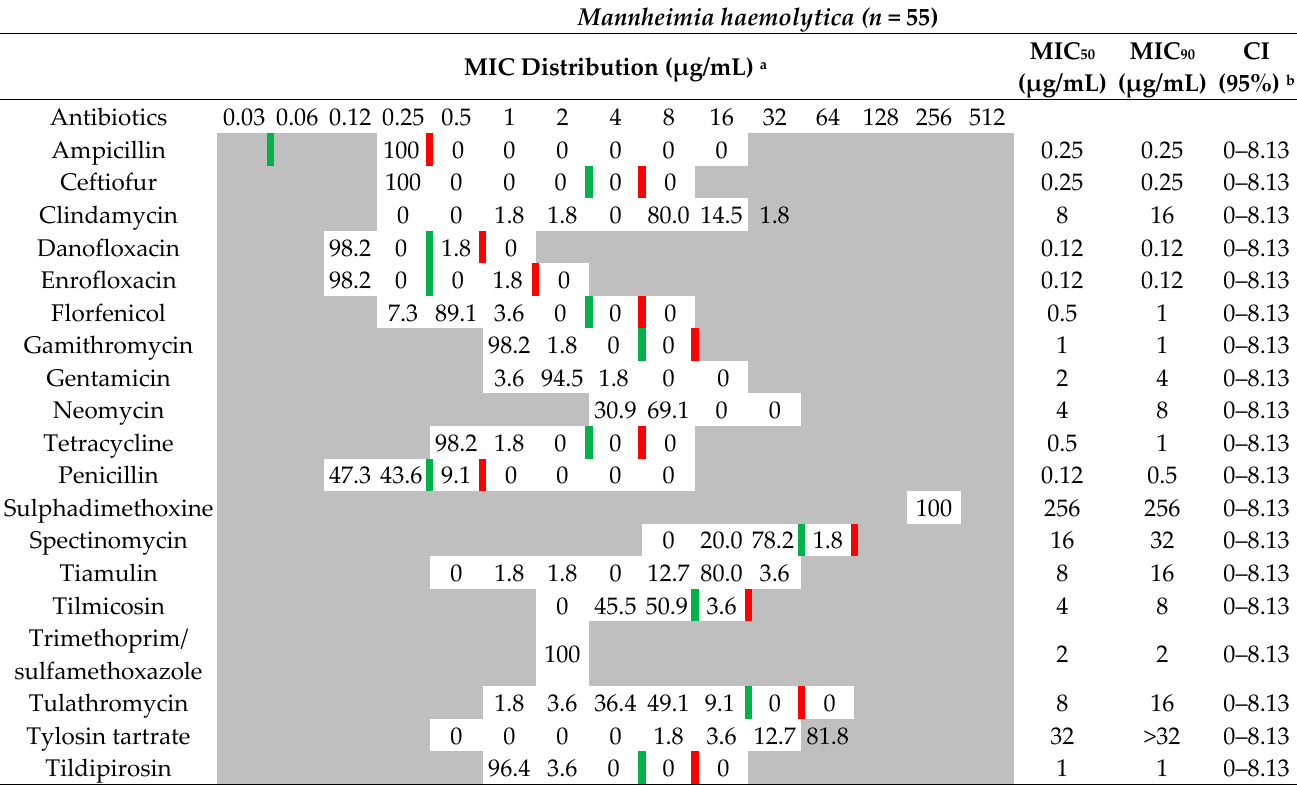
Table 3. MIC distribution frequencies of M. haemolytica cattle isolates from Australia 2014–2018.